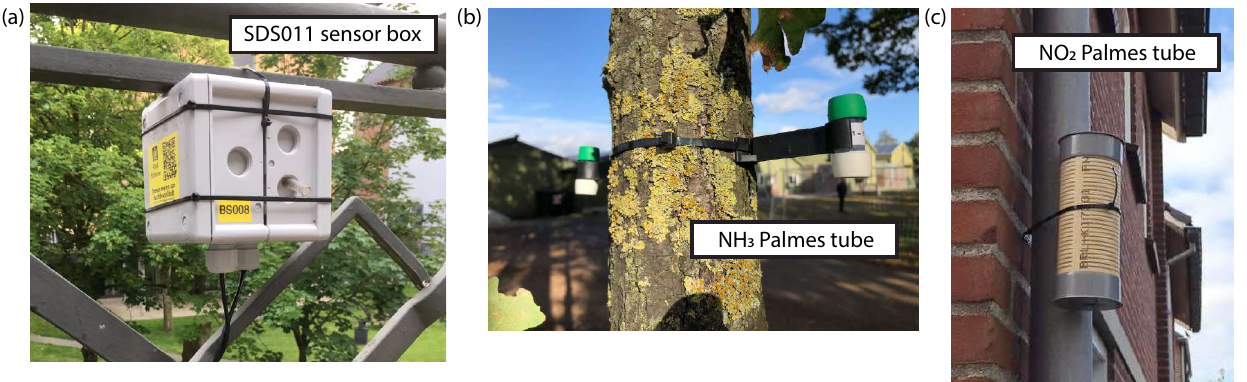
Figure 3. Photographs of PM sensorbox and Palmes tubes. ( a ) SDS011 sensorbox attached to a balustrade; ( b ) NH 3 Palmes tubes attached to a tree; ( c ) NO 2 Palmes tube, placed in a small shelter to minimize the influence of (traffic induced)